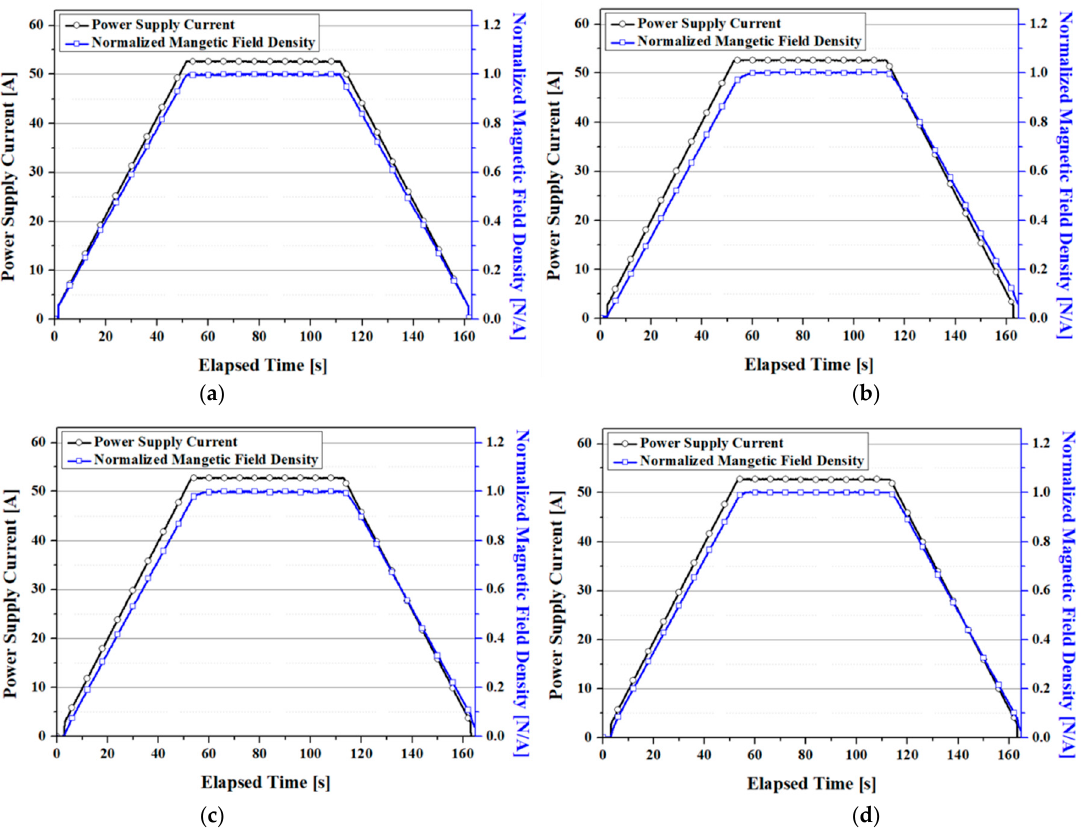
Figure 3. Charging/discharging test results of HTS coils: ( a ) Coil I, ( b ) Coil II, ( c ) Coil III, and ( d ) Coil IV.